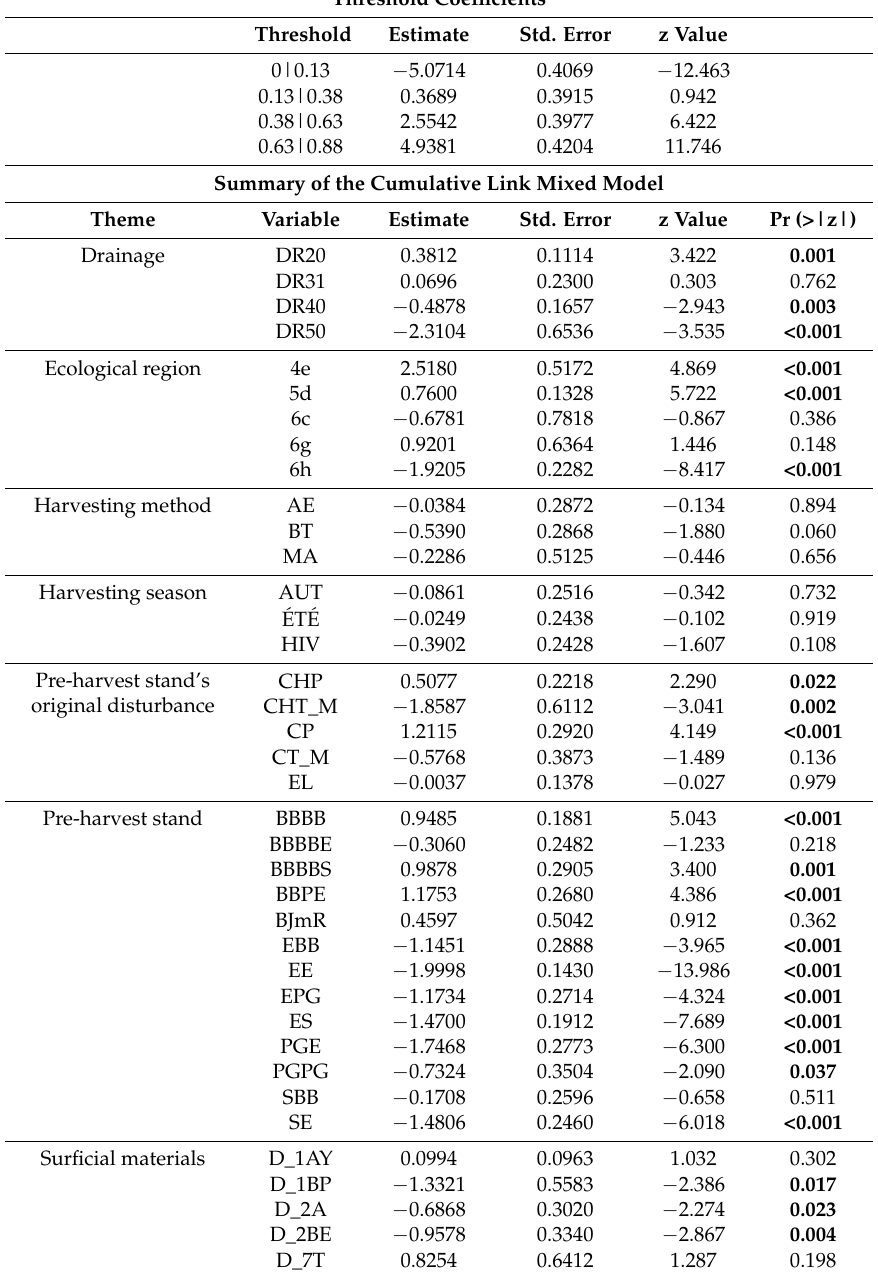
Table 4. Threshold coefficients and summary of the cumulative link mixed model predicting non-commercial hardwood percent cover as a function of harvesting and biophysical